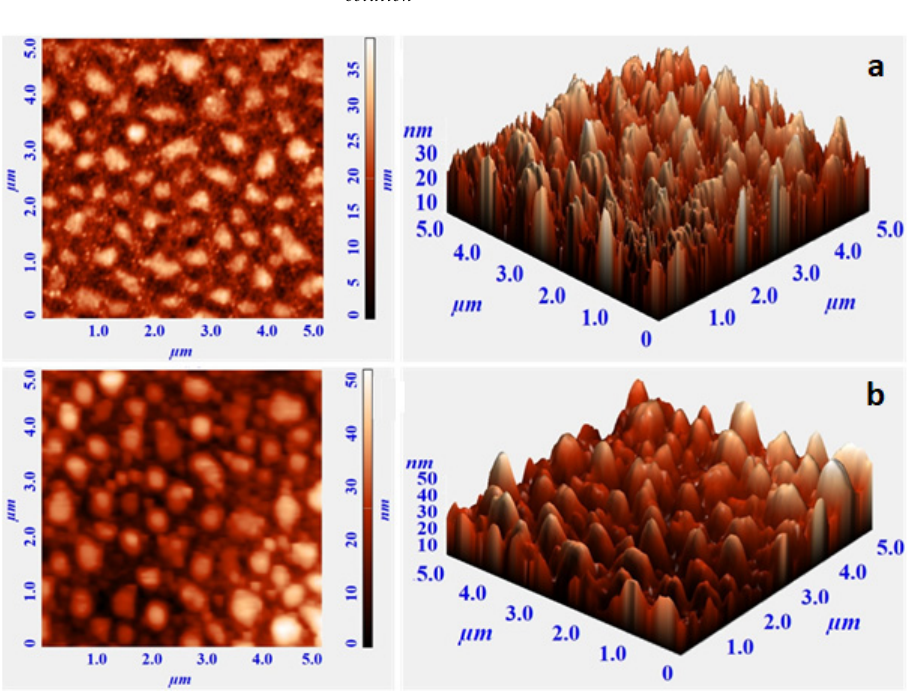
Figure 4. The 2D and 3D topographical images of ( a ) sample S1 and ( b ) sample